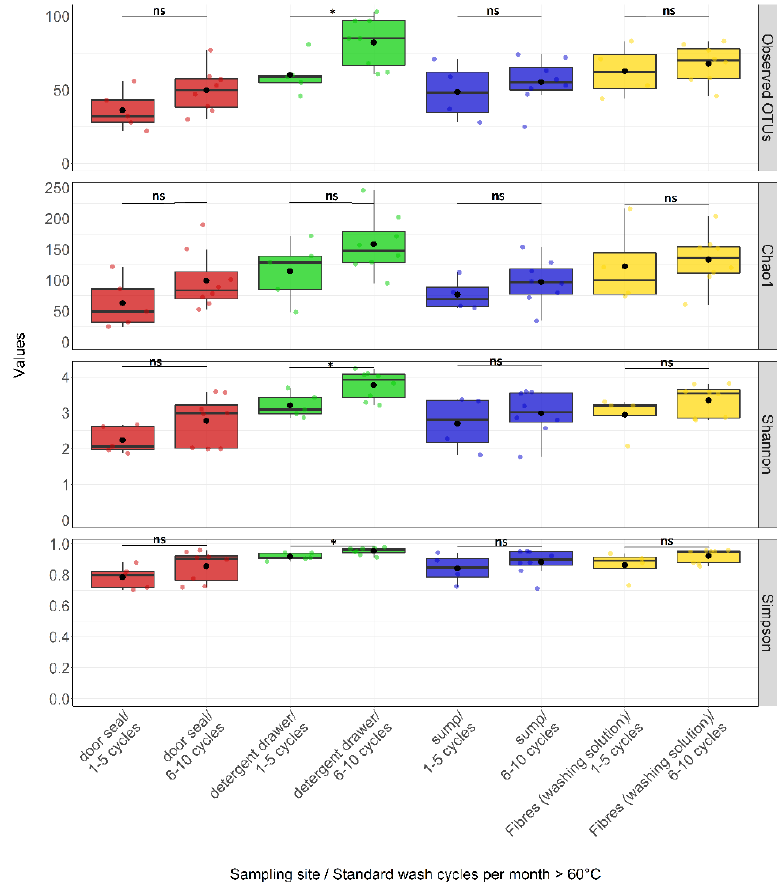
Figure 3. Box-whisker plots for the distribution of alpha diversity measures comparing sampling sites by standard wash cycle per month at temperatures ≥ 60 ◦ C. Samples were categorized by sampling sites and the number of standard wash cycle per month at temperatures ≥ 60 ◦ C. A box represent the 25% and 75% percentiles. The middle of the box represents the median. Mean values are displayed as black dots. The horizontal dashes above and below the boxes indicate the largest and smallest values, which were not classified as outliers. Colour indicates sampling site: door seal (red), detergent drawer (green), sump (blue) and fibres from washing solution (yellow). Coloured dots represent an individual sample. Statistical analysis was done using the Wilcoxon-Mann-Whitney-U tests for independent samples. p -values are indicated by asterisks, p < 0.05 (*) and ns = not significant.